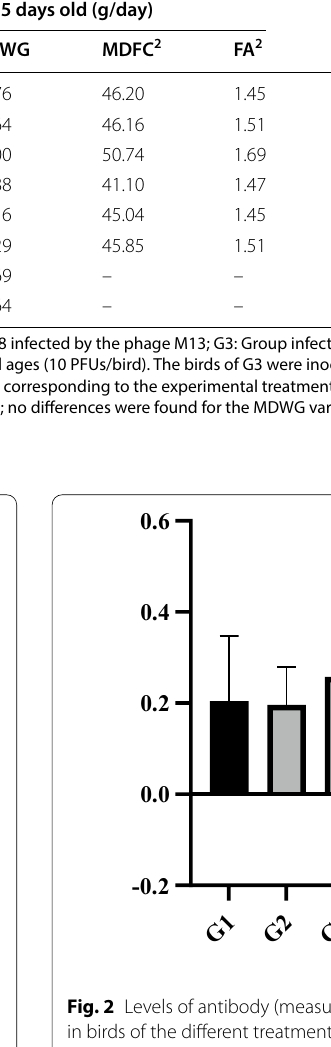
tional file 1: Table S3). Besides, 13 days after the last inoc- ulation (at 28 days of age), the birds had 1.2 log PFU/g of